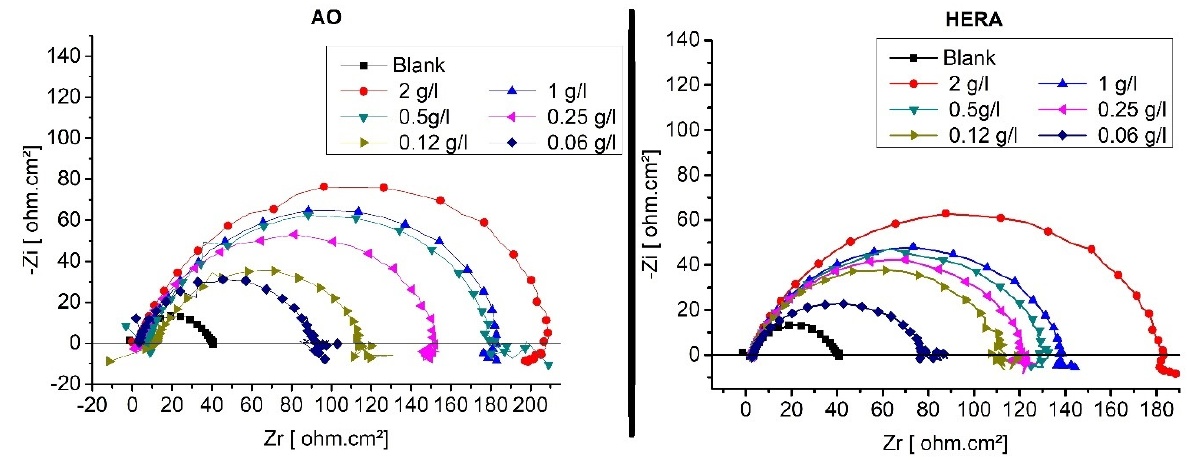
Figure 6. Nyquist plots for mild steel in 1 M HCl in presence and absence of AO and HERA. Table 4. EIS parameters of mild steel in 1 M HCl in presence and absence of AO and HERA.